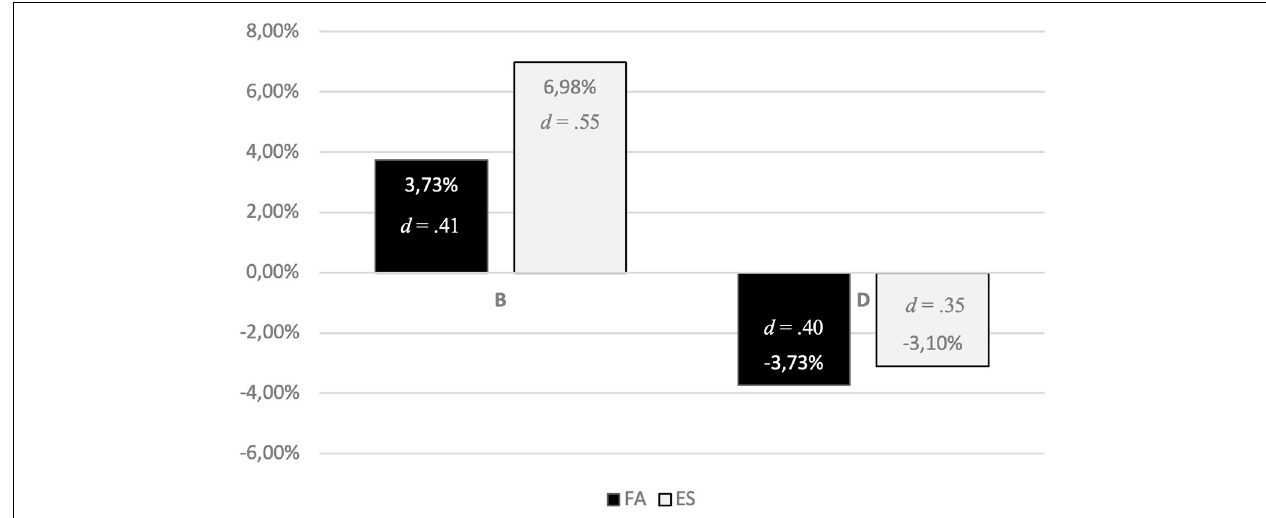
FIGURE 3 | Changes in attachment classification within the 2-year